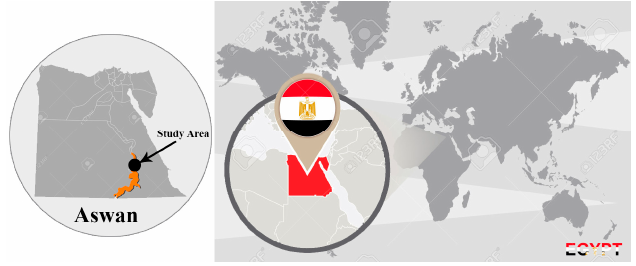
Figure 3. The study area in relation to Egypt and the world.